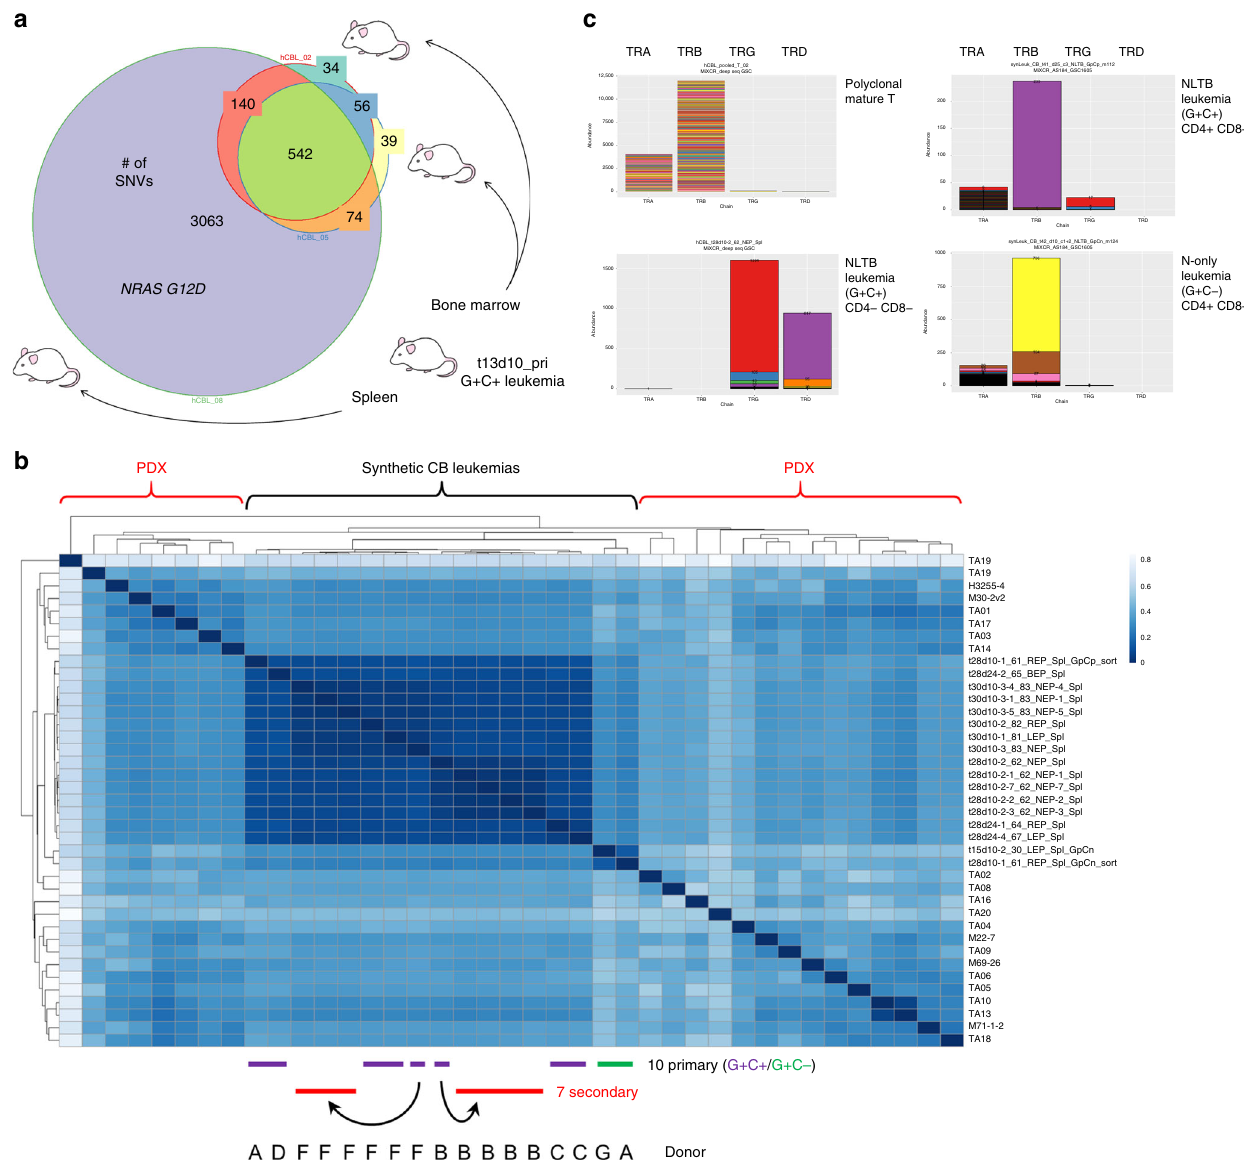
Fig. 4 Synthetic CB leukemias exhibit clonal evolution in vivo and are highly similar to PDXs. a Venn diagram of single nucleotide variants (SNVs). FACS- sorted G + C + cells from bone marrow or spleen of a low-level engrafted primary recipient mouse were injected into secondary recipients. G + C + cells were FACS sorted from clinically morbid secondary recipients and genomic DNA extracted for whole exome sequencing. b Unsupervised hierarchical clustering of synthetic NLTB CB leukemias and PDX T-ALLs based on RNA-seq data. Following batch correction with ComBat, correlation distances (1 − Spearman coef fi cient) across 39 samples (17 synthetic CB leukemias + 22 PDX) were calculated using the top 1000 variable genes within the PDX sample set. Individual CB donors were discriminated by STR pro fi ling. Darker blue indicates greater similarity. PDX RNA-seq data are from the PRoXe repository (NCBI SRA Accession SRP103099). Color scale indicates (1 − Spearman) correlation distance. Darker blue indicates greater similarity. c TCR clonality by MiXCR analysis of RNA-seq data. Distinct CDR3 regions are indicated by alternating colors within each sample; matching colors across samples are coincidental and do not indicate sequence identity. Mature T-cell control shows polyclonal TRA/TRB. The depicted G + C + CB leukemias show mono/ oligoclonal patterns for TRG/TRD and TRB, respectively. The depicted G + C − CB leukemia shows oligoclonal